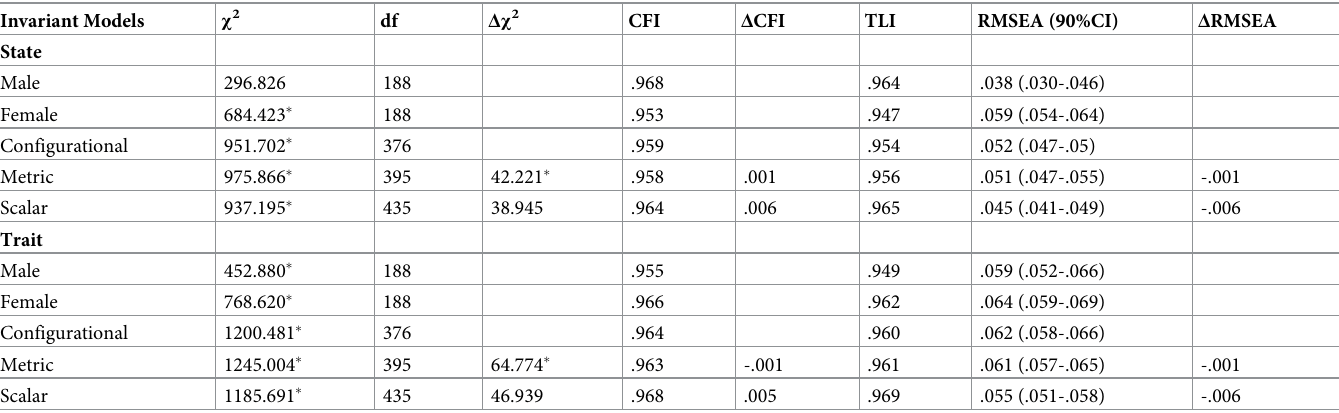
Note . Statistics: Chi-square ( χ 2 ); Comparative fit index (CFI); Tucker and Lewis Index (TLI); Standardized Root Mean Squared Residual (SRMR); Root Mean Square Error of Approximation (RMSEA). � p <